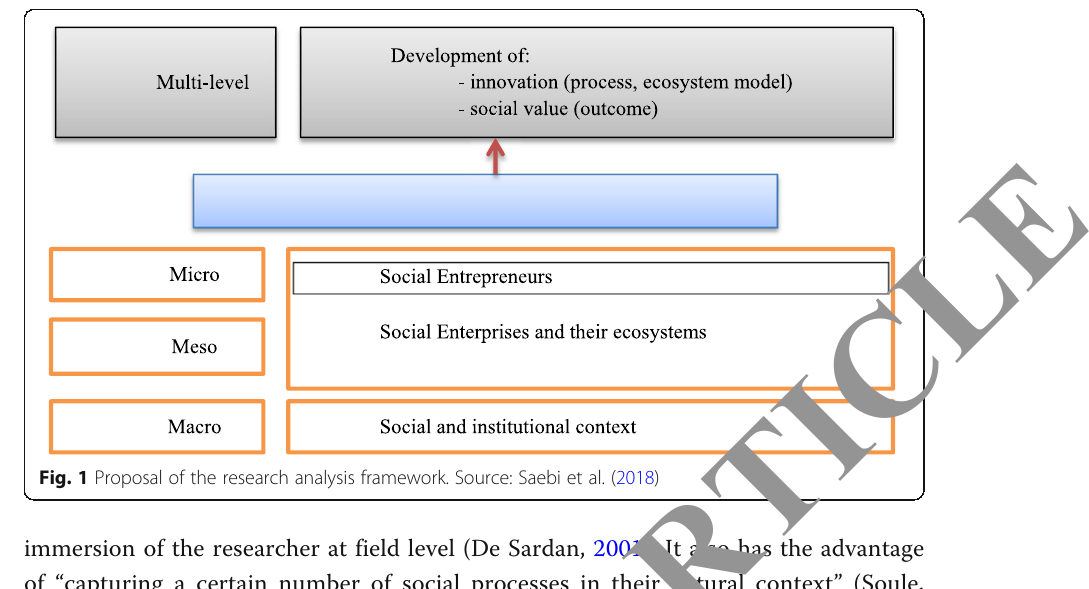
Fig. 1 Proposal of the research analysis framework. Source: Saebi et al.